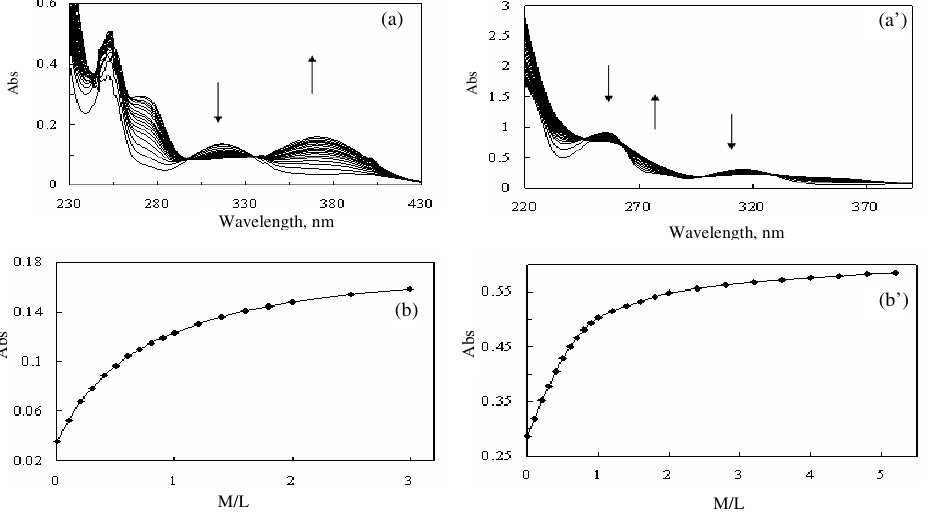
Figure 1. UV-Vis spectra for titration of BHAED (a) and BSPHEN (a´ ) (3.8 × 10 -5 M) with UO 22+ ion in acetonitrile (T = 25 ˚C, I= 0.05 M and 0.05 M TEAP) and the corresponding absorbtion mole ratio curves at 362, 420 nm respectively (b,b’) and curve fitting (c,c ΄